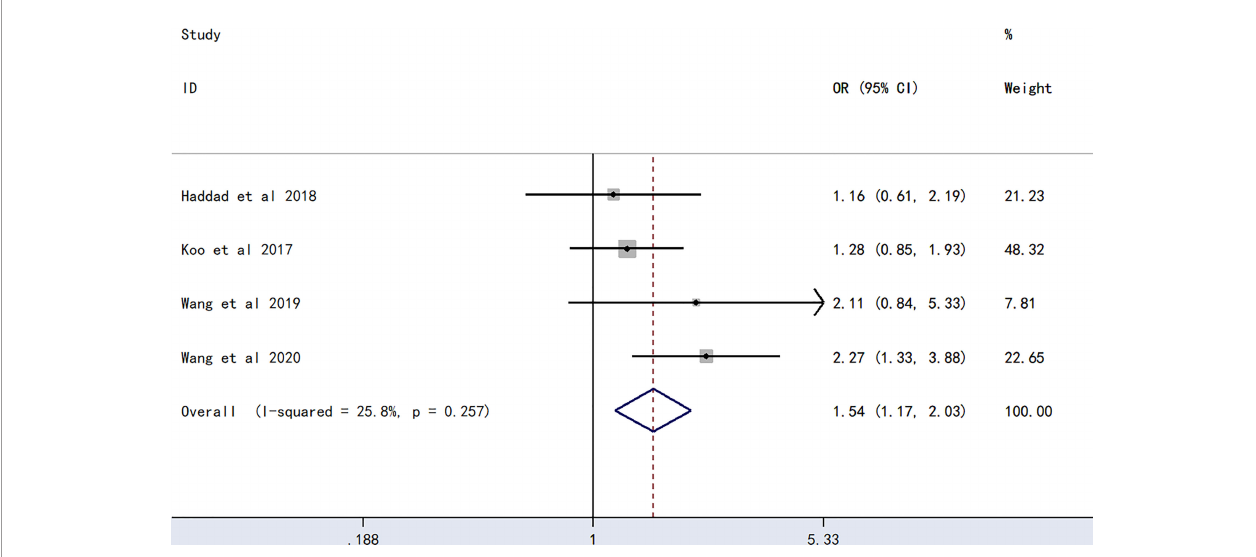
FIGURE 3 | Forest plot evaluating the association between PICC-associated VTE and the prevalence of A blood group.